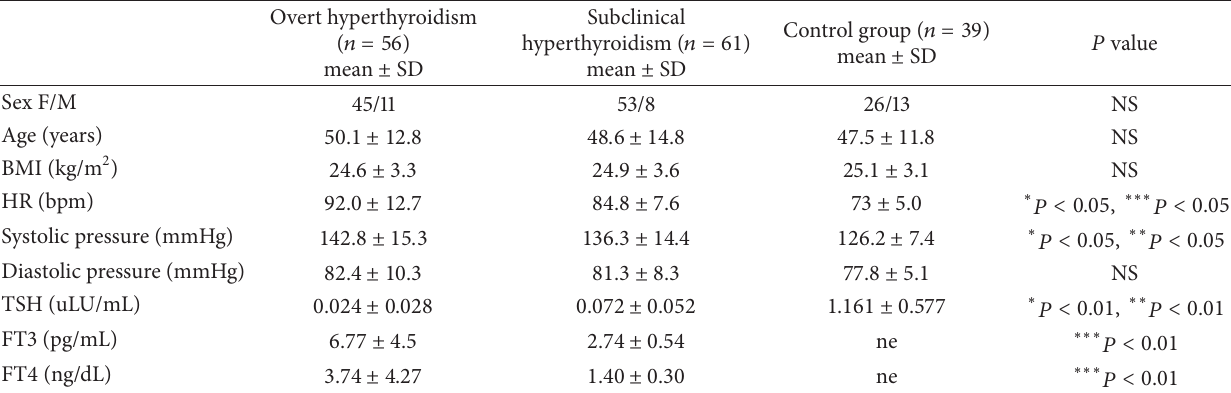
Table 1: The clinical characteristics of the groups studied.